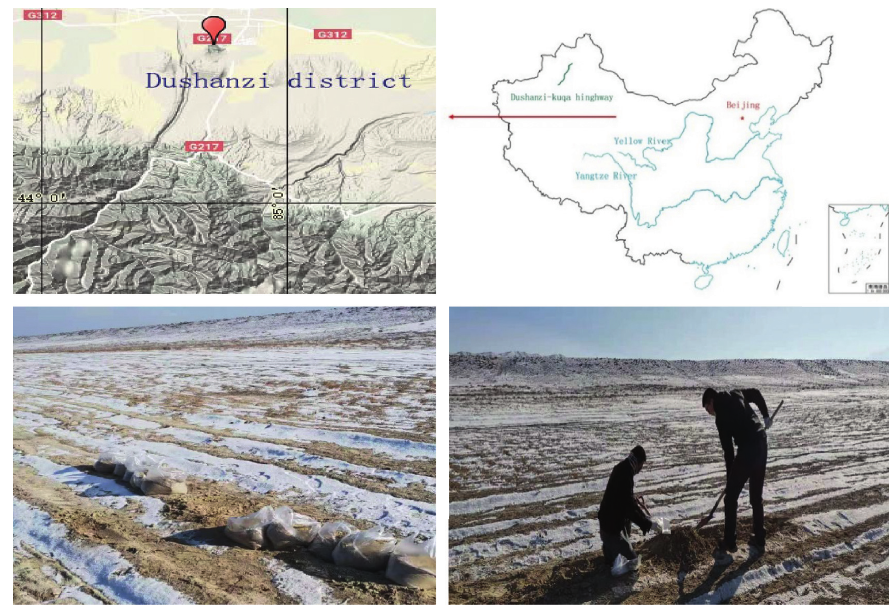
Figure 1: The sampling process. Table 2: Sample soluble salt ion test